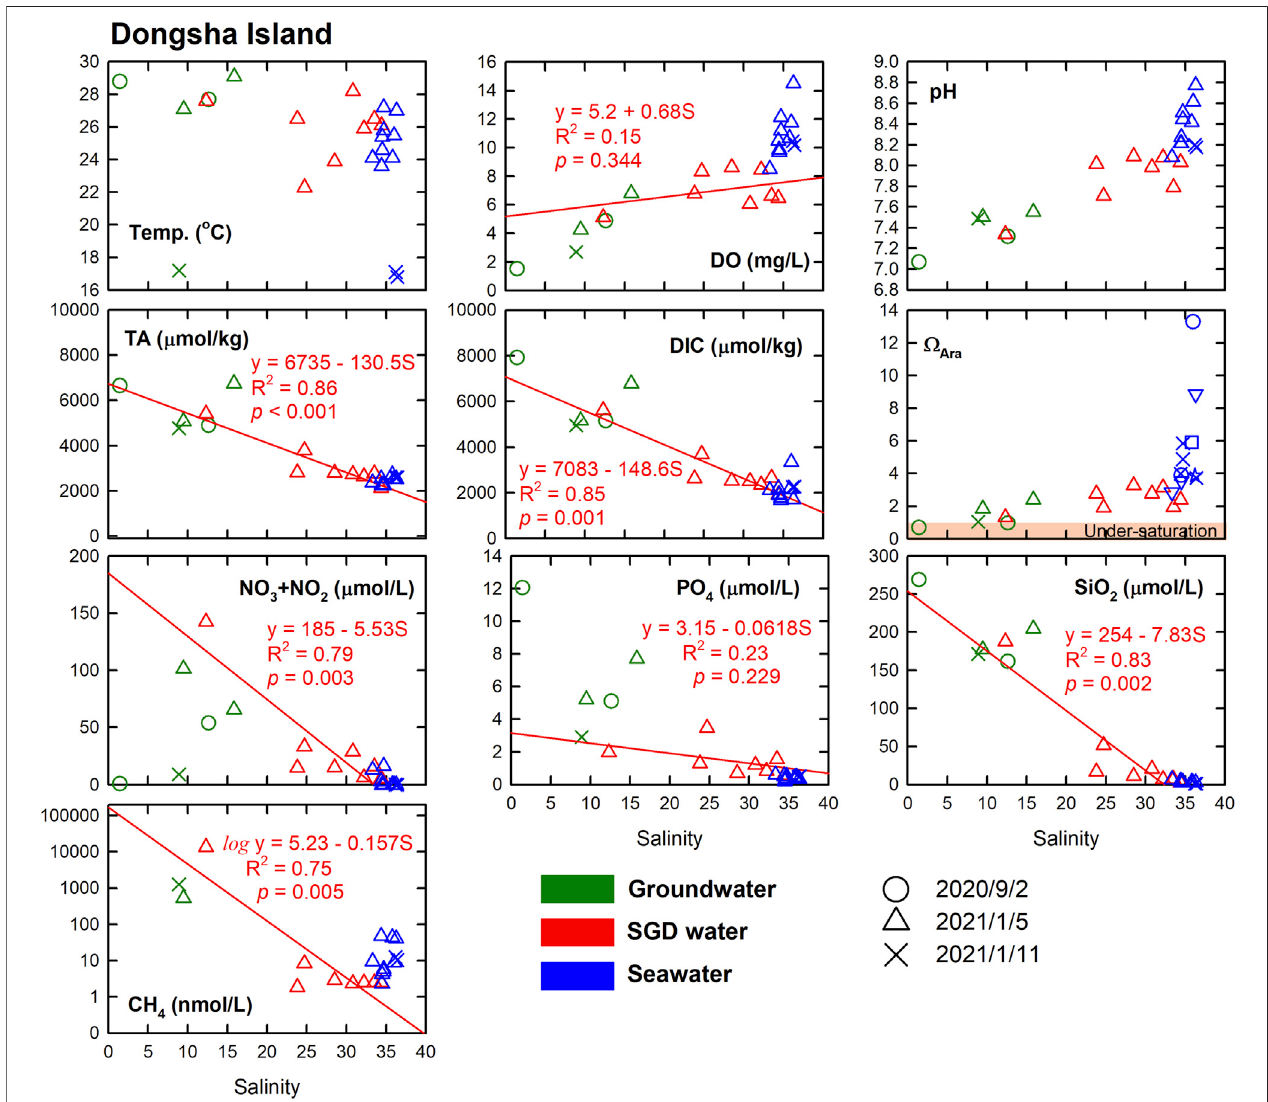
FIGURE6| Temperature,DO,pH,TA,DIC, Ω Ara ,NO 3 − +NO 2 − ,PO 43 − ,SiO 2 ,andCH 4 vs.salinityofgroundwater,SGDwater,andseawaterinDongshaIsland.The groundwater, SGD, and seawater are in green, red, and blue, respectively. The red lines extended to the axes and equations show the linear regressions for the conservative parameters of the SGD